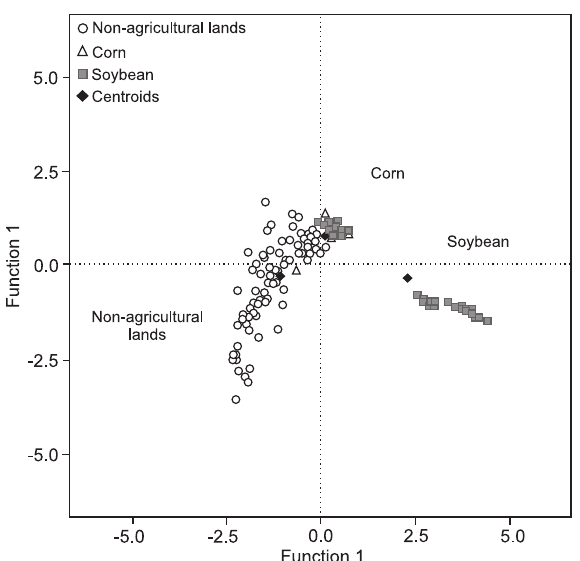
Figure 2. Differences between the average scores of Soybean, Corn and Non-agricultural lands, generated by the discriminant function scores.